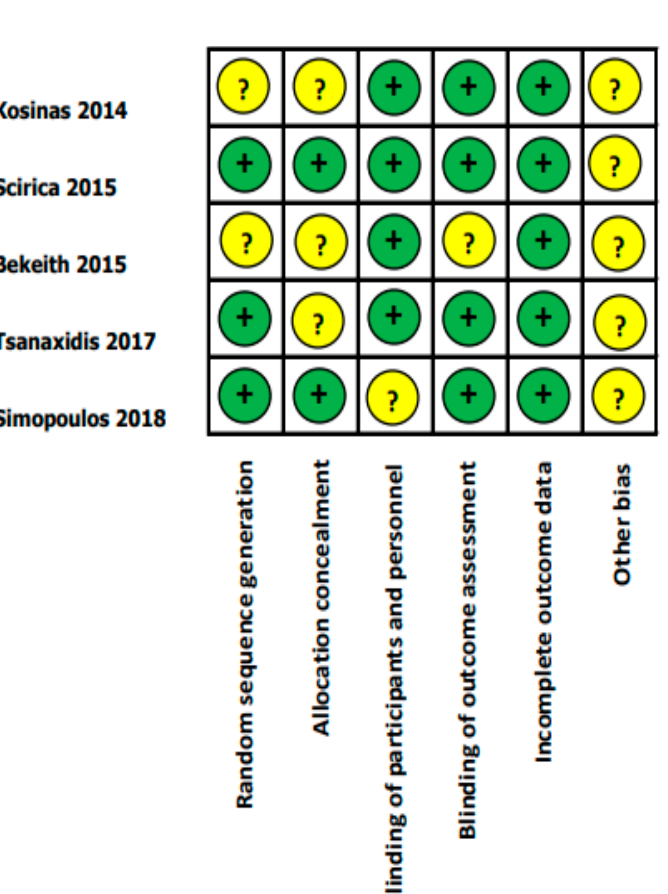
Figure 2. Cochrane risk of bias assessment of each included RCT. + indicates low risk of bias; ? indicates unclear risk of bias.